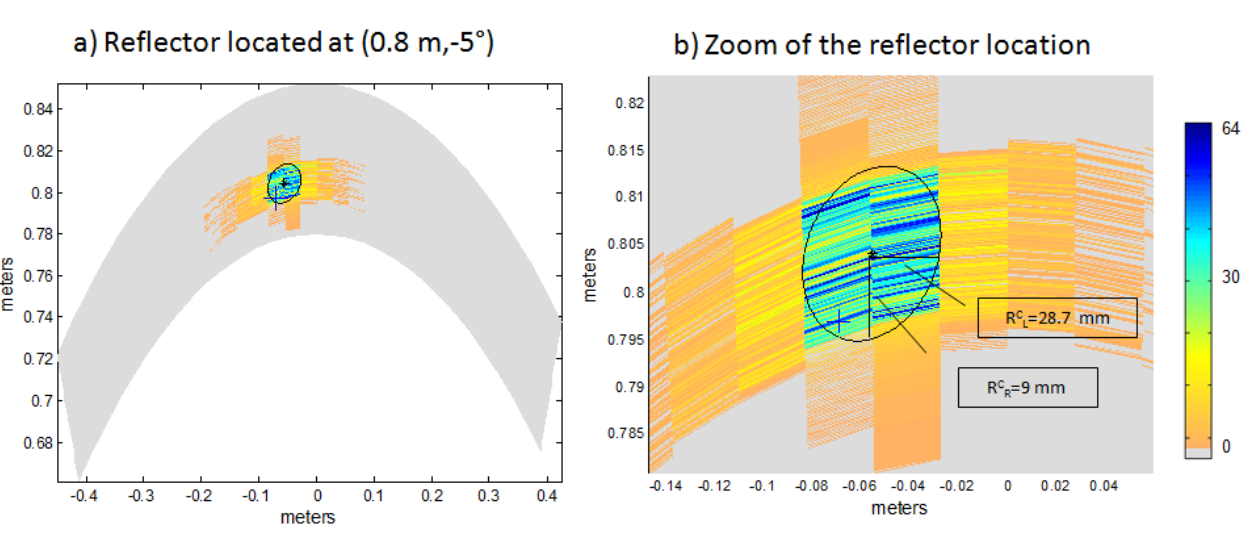
(b) Zoom of the reflector location.